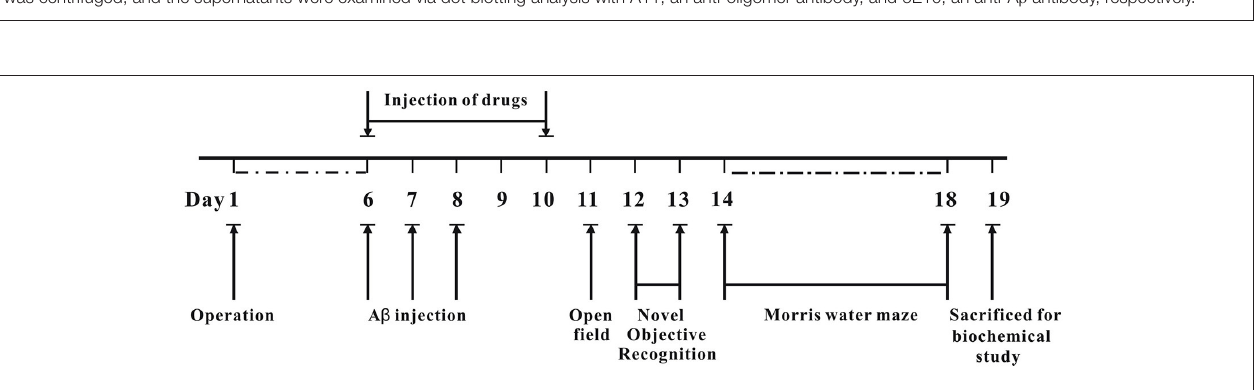
FIGURE 1 | 7Bio is one of the most potent chemical to inhibit A β oligomer-induced neuronal death in SH-SY5Y cells. (A) SH-SY5Y cells were treated with indirubin-3-oxime (I3O), indirubin-3-(2,3-dihydroxypropyl)oximether (I3DO), indirubin-3-monoxime-5-sulphonic acid (I3OS), 5-iodo-indirubin-3-monoxime (II3O), indirubin derivative E804 (E804), or 7Bio at various concentrations as indicated. After 2h, 1.5 µ M A β oligomers were added. The MTT assay was used to measure cell viability at 24h after the addition of A β oligomers. (B) 7Bio prevents but does not rescue A β oligomer-induced neurotoxicity in SH-SY5Y cells. SH-SY5Y cells were exposed to 1.5 µ M A β oligomer with 2h pre-treatment (2h) or co-treatment (0h) of 10 µ M 7Bio. The MTT assay was applied at 24h after adding A β oligomer. Data, expressed as percentage of the control, were the mean ± SEM of three separate experiments; ## p < 0.01 vs. the control group, * p < 0.05 and ** p < 0.01 vs. A β oligomer group (ANOVA and Tukey’s test). (C) 7Bio reduces A β oligomer formation. A β peptide was co-incubated with 7Bio at the indicated doses for 2 days. Solution was centrifuged, and the supernatants were examined via dot blotting analysis with A11, an anti-oligomer antibody, and 6E10, an anti-A β antibody, respectively.